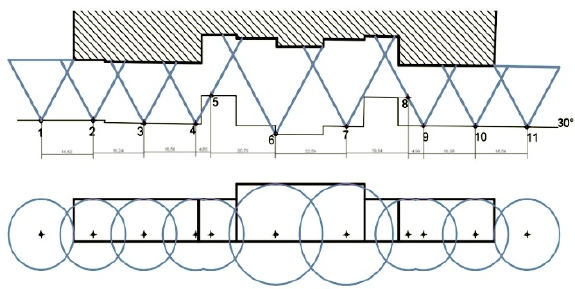
Figure 11. Plan and front view of the project scans with closeness value between 4,2 m and 6,0 m – graphic